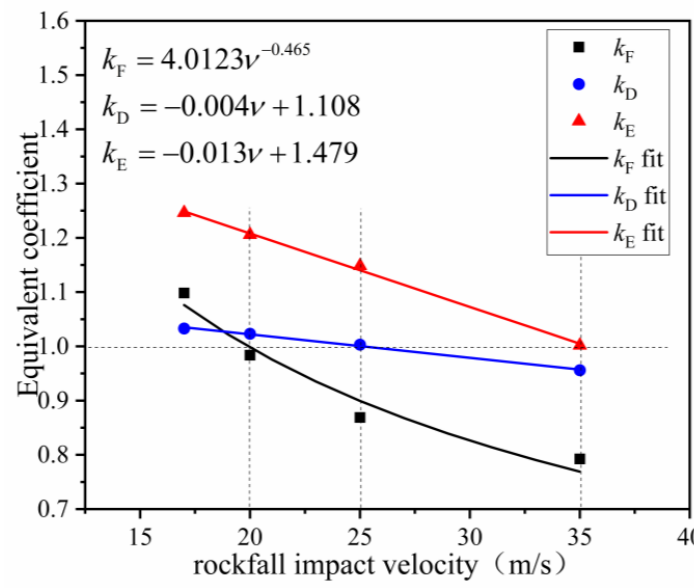
Figure 15. Equivalent coefficients at different rockfall impact velocities.